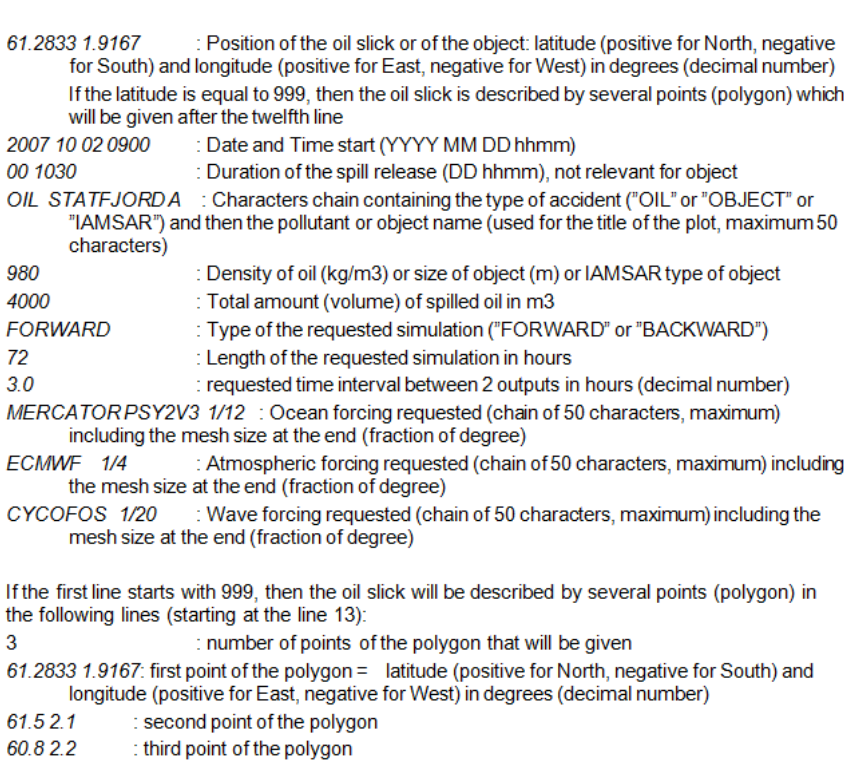
Fig. 5. Sample of the common input file used to provide the necessary information to the oil spill model including explanations for each field.